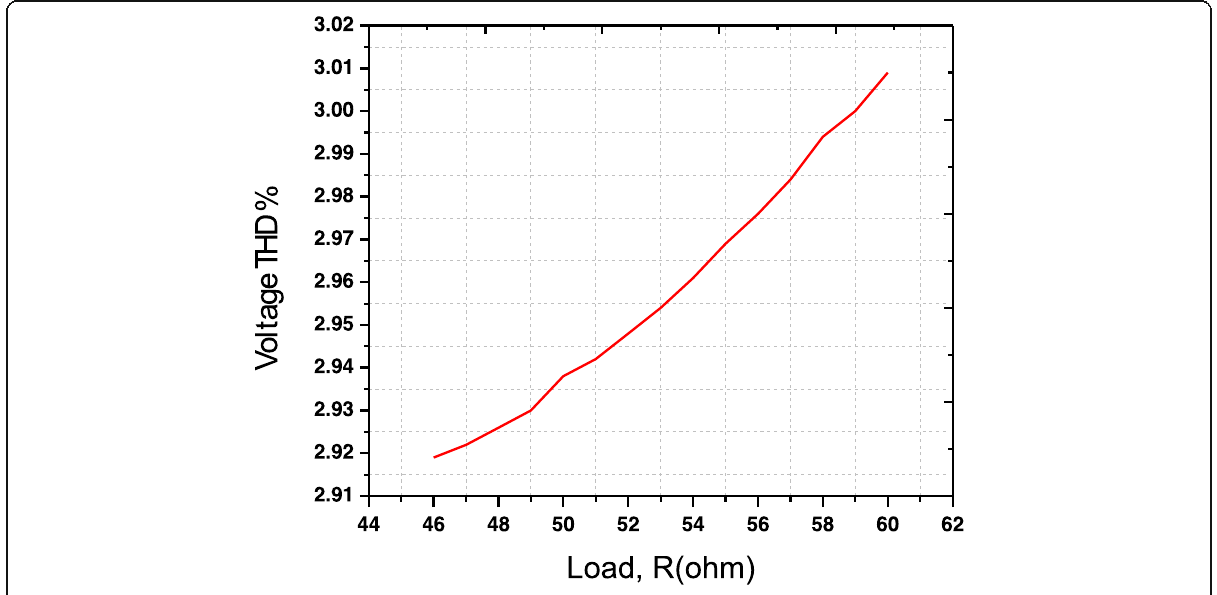
Fig. 9 Voltage THD versus the load, obtained by optimization